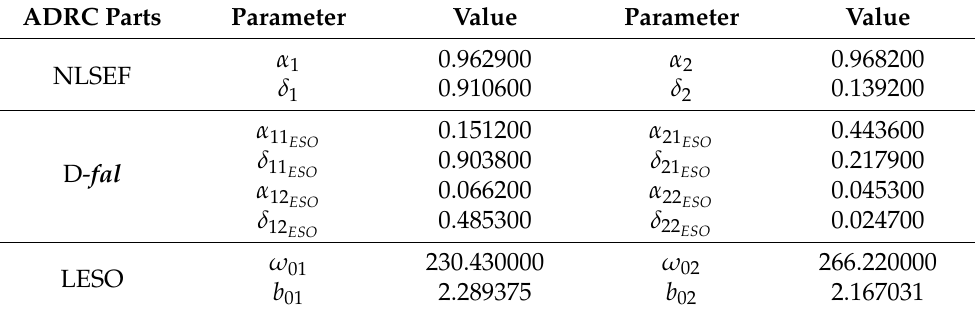
Table 12. D f al -ADRC